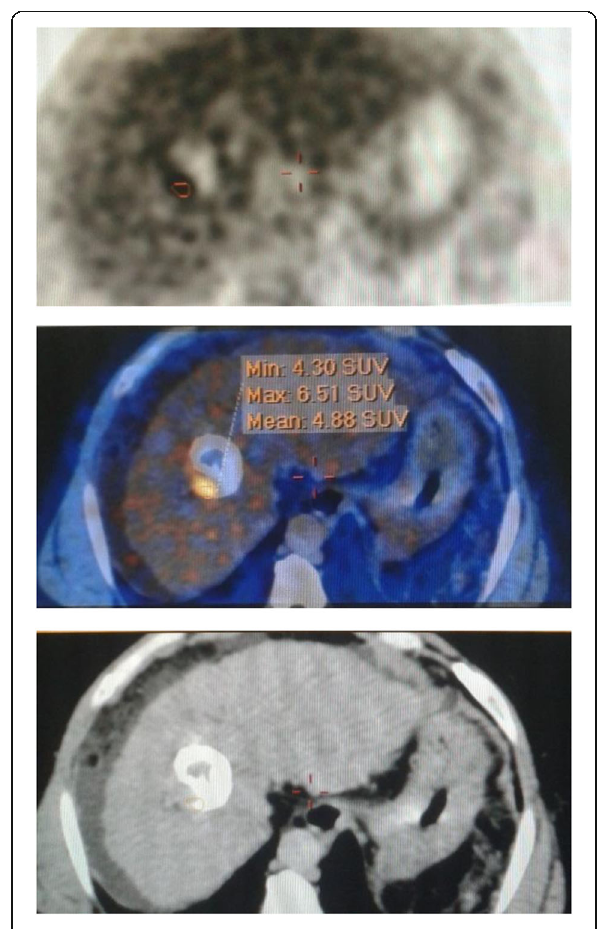
Fig. 1 A 57-year-old male underwent TACE for upper segment right lobe HCC with elevated AFP after TACE PET CT revealing focal residual viability related to the posterolateral aspect of the lesion with 6.5